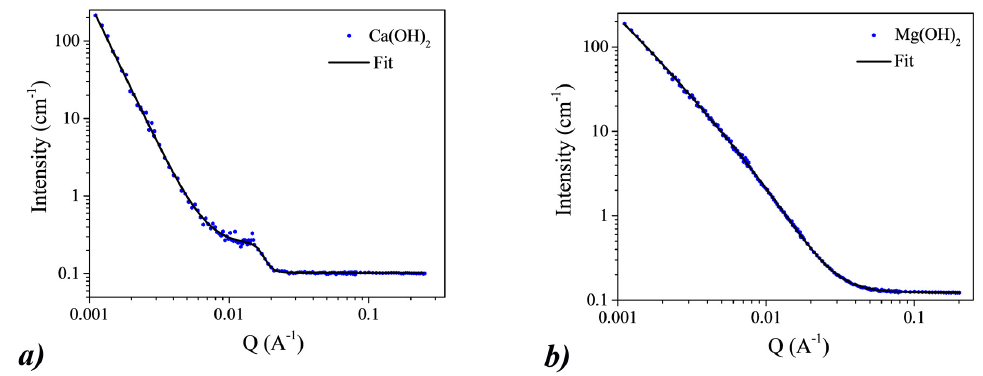
Figure 7. Small-angle neutron scattering (SANS) results on CH ( a ) and MH ( b ) nanoparticles. The experimental error bars may not be visible because they are smaller than the symbols for the experimental data. The fitting curves are represented by continuous